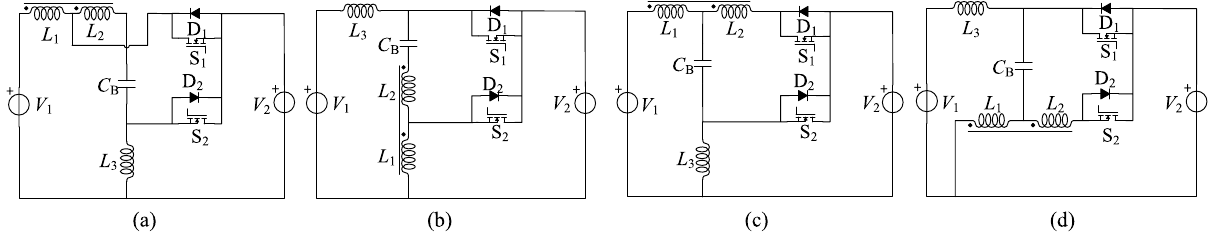
Figure 2. Bidirectional high-gain Cuk circuits are formed by the same-direction coupling, ( a ) S 1 -tap, ( b ) S 2 -tap, ( c ) C B -tap 1, ( d ) C B -tap